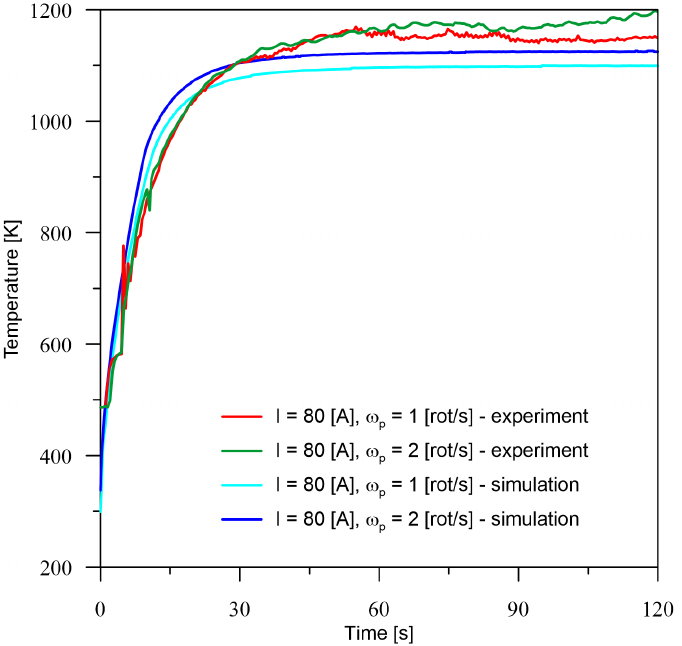
Figure 6. Comparison of the results of the experiment and the numerical model for I = 80 A. Based on the differences between the obtained values from the numerical model and experiment presented in Table 2, it can be seen that the percentage error is no greater than 6.5%. For the smallest analysed current value, the larger error occurs in the zone before temperature stabilisation and drop to about 1% after the process stabilises. For the current of 80 A, overestimation can be observed for both cases at the initial time and stabilisation of the error at a level of up to 5% in the area of constant thermal conditions. On the other hand, for a current equal to 60 A, it can only be seen that the error is more or less at a constant level in the area of process stabilisation and this is due to the overestimation of temperature values by the numerical